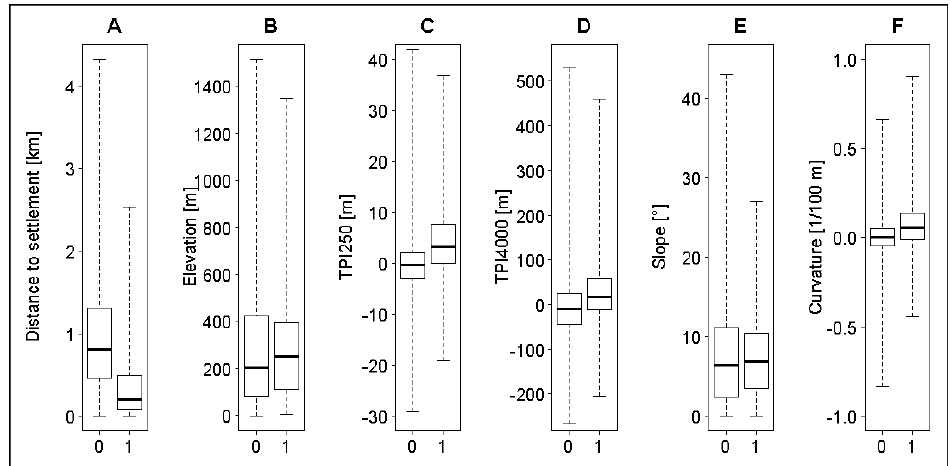
Figure 10: Box-whisker-plots showing median (solid lines), quartiles (boxes) and data extremes (dashed lines) of SaS (1) and pseudo-absences (0) along the significant metric variables of the logistic regression